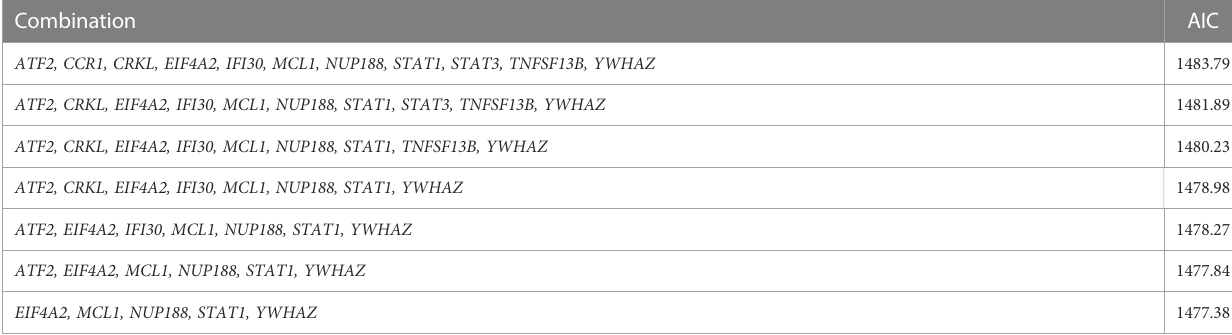
TABLE 1 Multivariate cox regression analysis of different combination of CSIRGs by the Akaike information criterion (AIC).